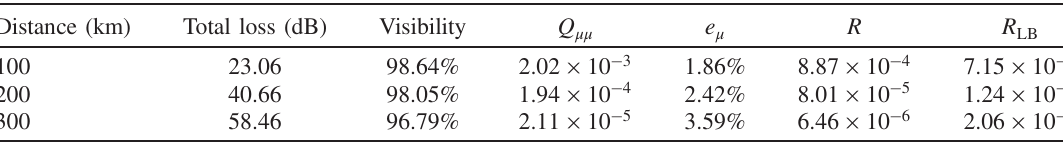
TABLE I Experimental results. Distance